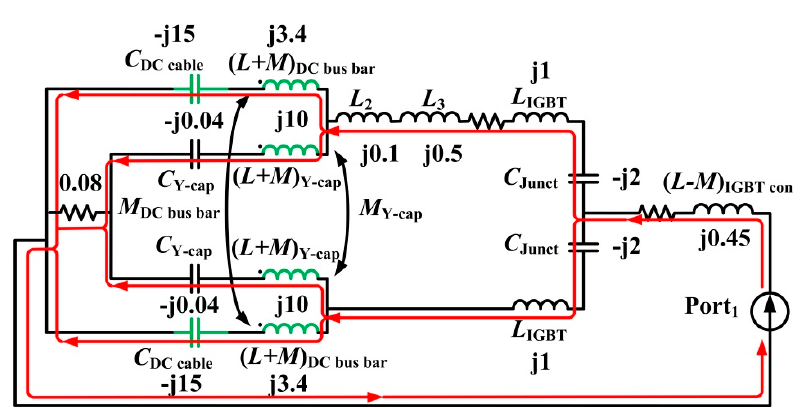
Figure 6. Equivalent circuit at 6 MHz.